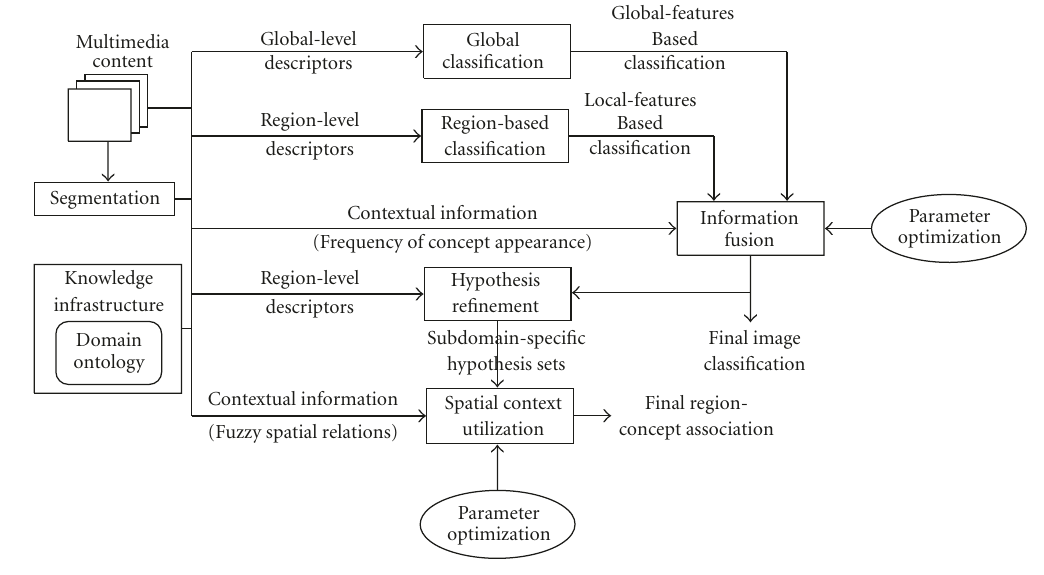
Figure 2: Detailed system architecture.